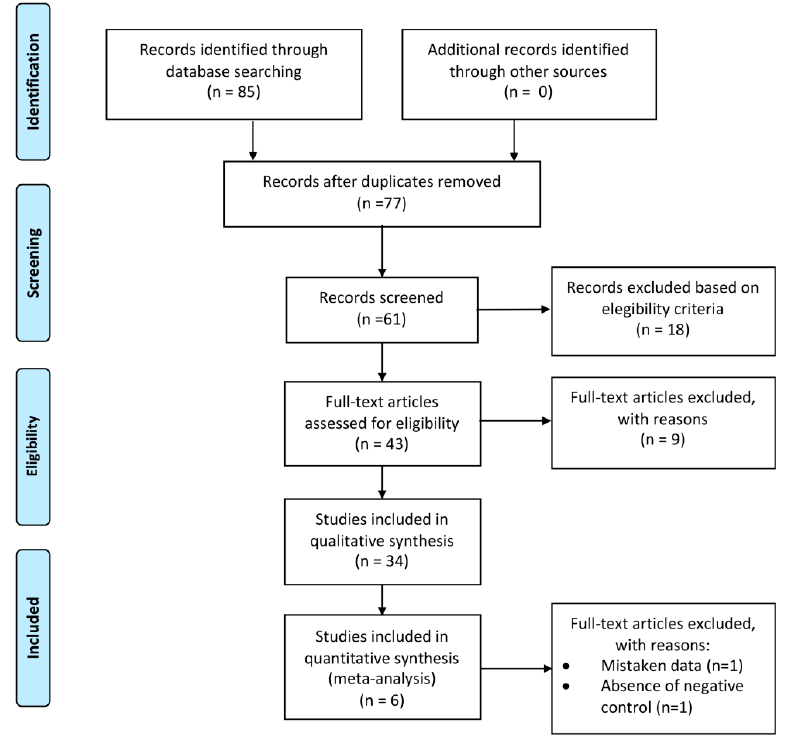
Figure 1. Flow diagram for our systematic review based on the PRISMA Guidelines.